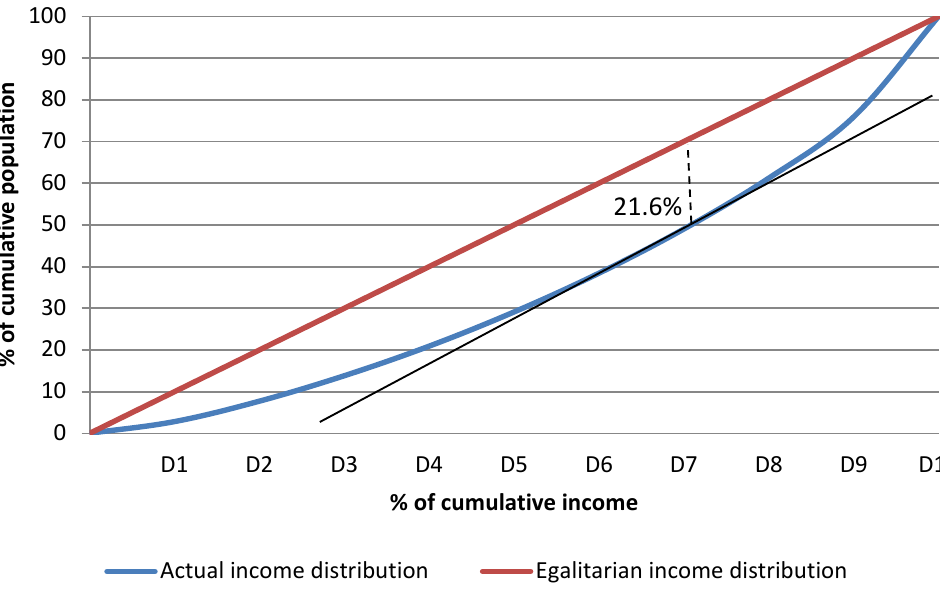
Figure 8 . Lorenz curve and Hoover index for the EU-28 (2015). Source: Own elaboration based on statistics from